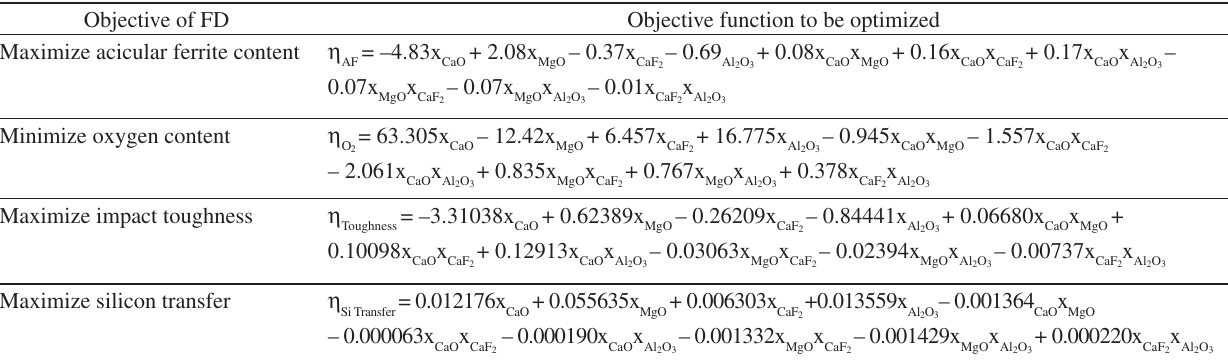
Table 2. The Objectives of the flux designer and the corresponding models. Objective of FD Objective function to be optimized Maximize acicular ferrite